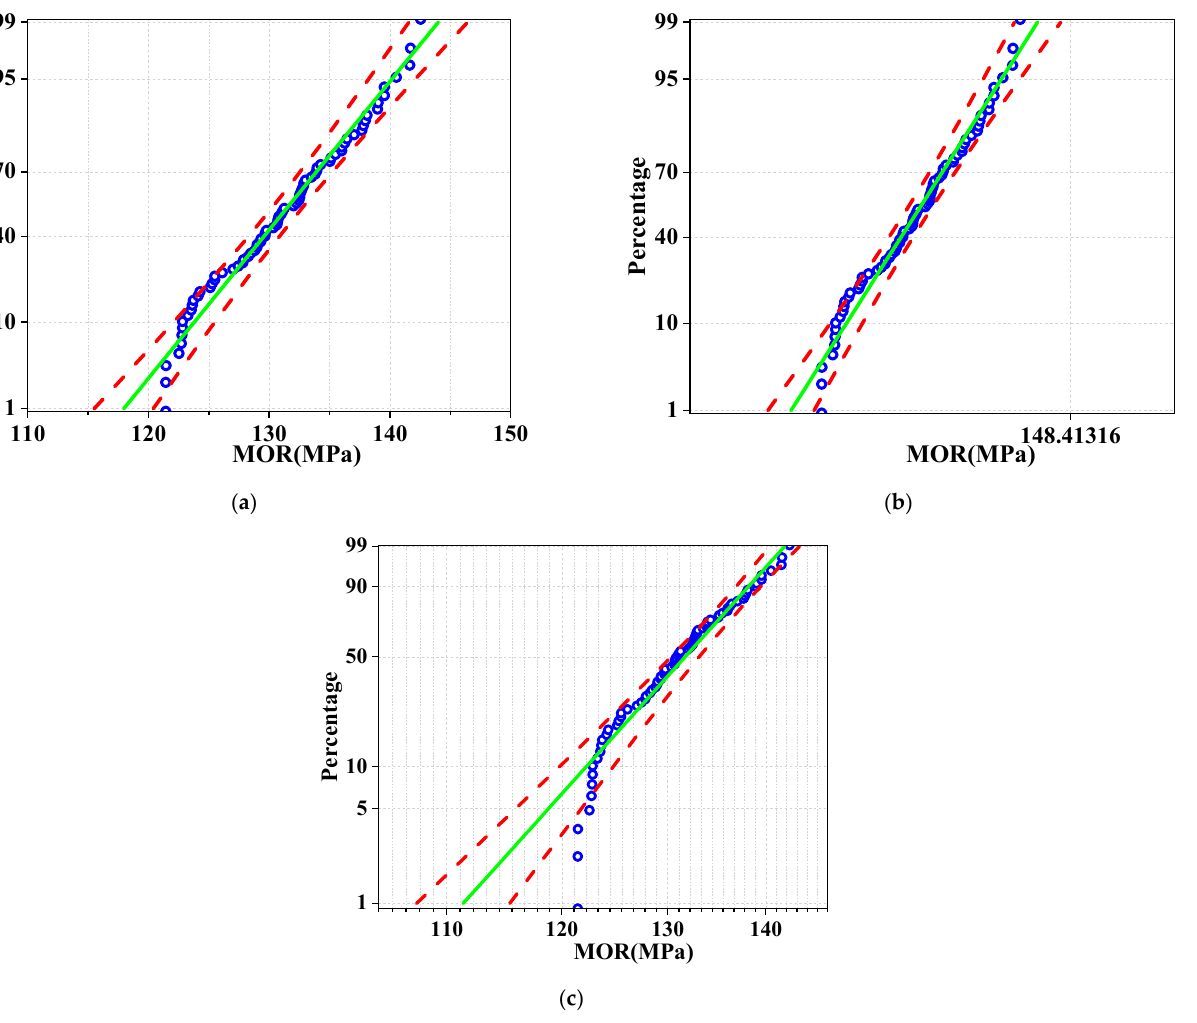
Figure 6. P–P diagram of 75% data under different probability distribution types (grade II): ( a ) normal; ( b ) lognormal; ( c ) Weibull. (blue: Weibull; red: Normal distribution; green: Lognormal